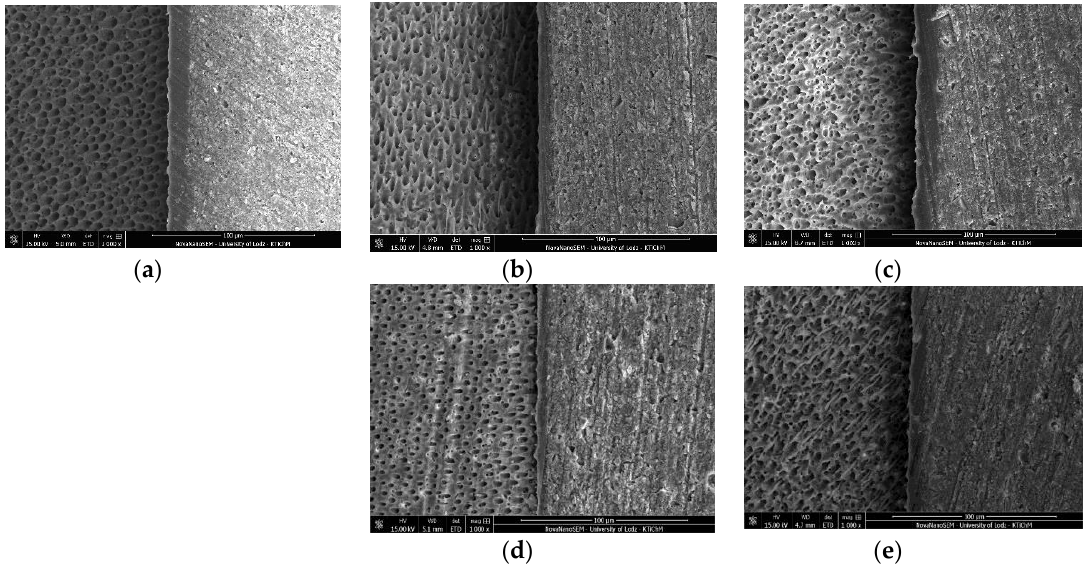
Figure 3. SEM micrographs of dentin specimens treated with Single Bond Universal: ( a ) 1A20 (control); ( b ) 2A20; ( c ) 3A20; ( d ) 2A40; ( e ) 3A60; mag. 1000 x.